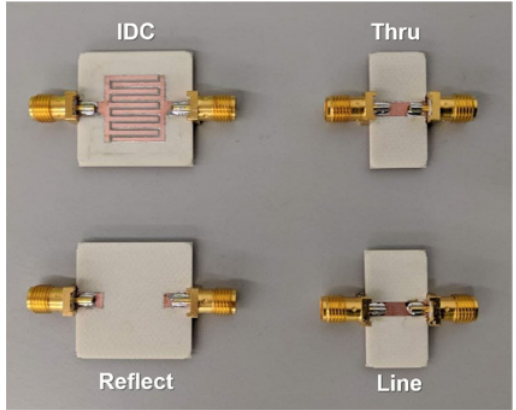
Figure 2. Boards fabricated using the prototype PCB milling machine: the IDC device and the thru, reflect and line